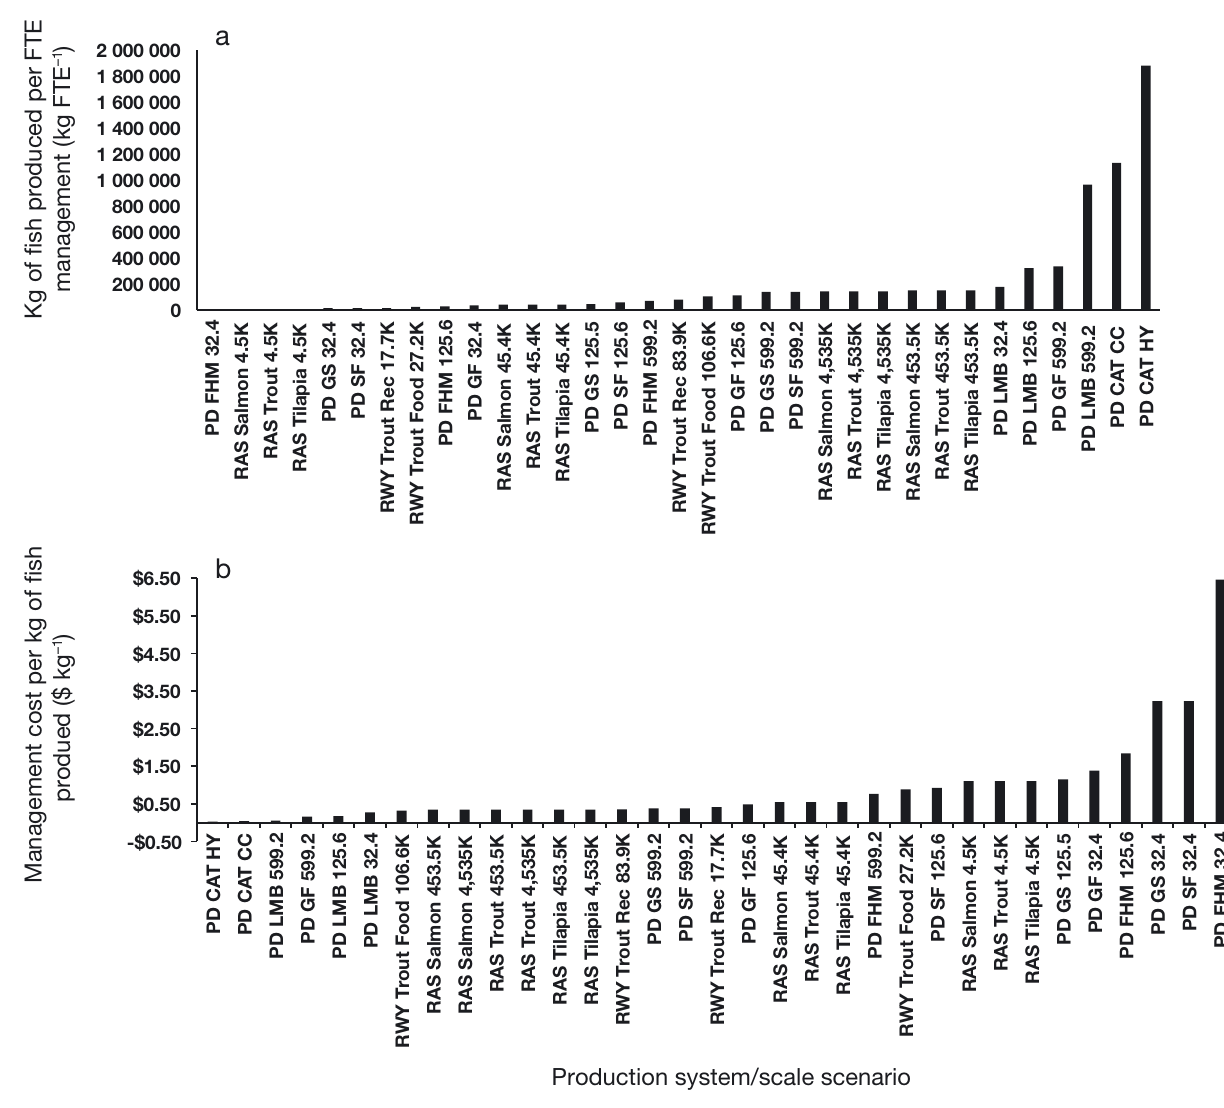
Fig. 6. (a) Management productivity and (b) management cost across production systems. Abbreviations as in Figs. 1 &